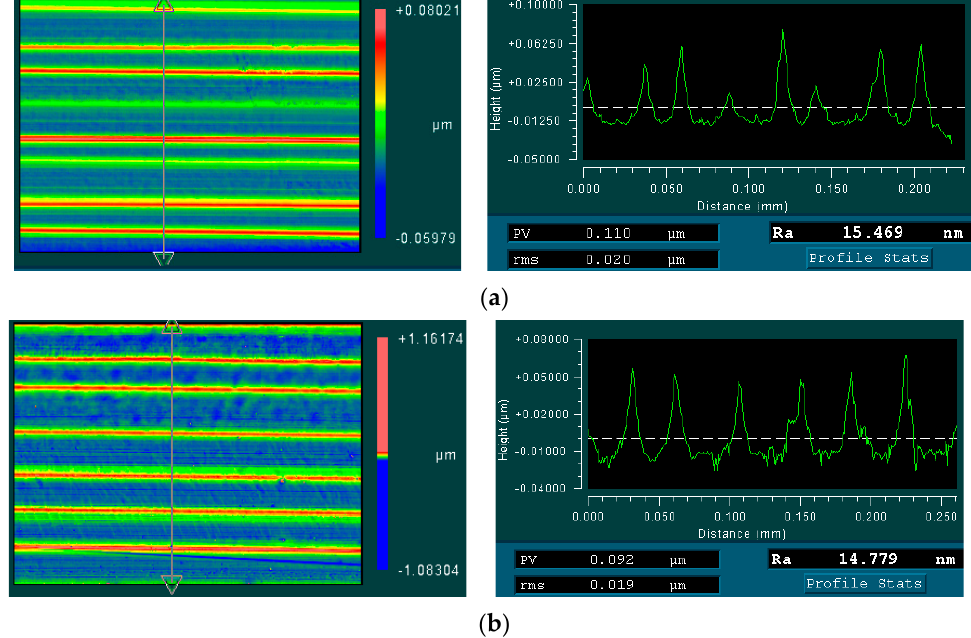
Figure 12. Magnetic-field-assisted turning on surface morphology and profile, ( a ) surface morphology and profile without magnetic, ( b ) surface morphology and profile with magnetic.